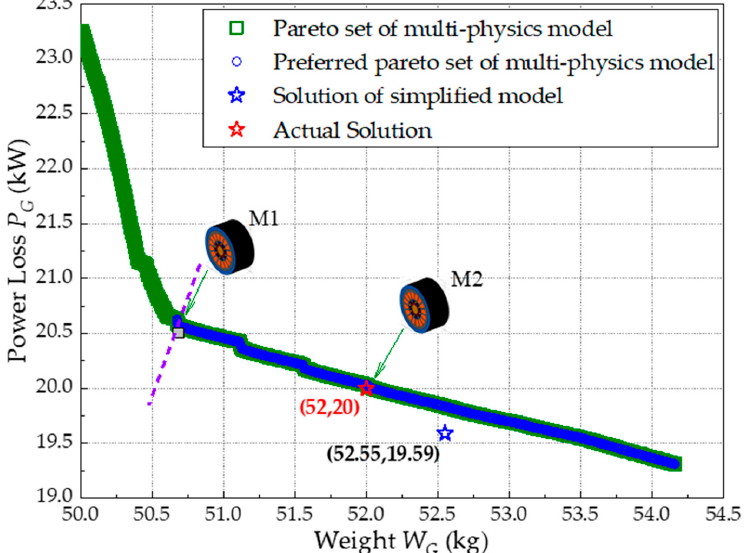
Figure 9. Pareto results of models and actual values.